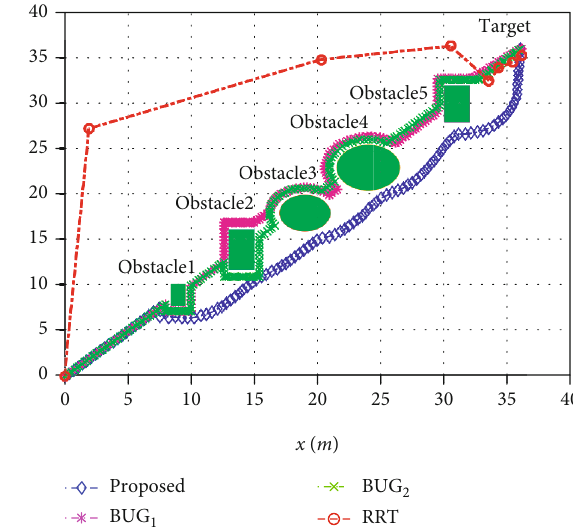
Figure 13: Scenario 1: the result of path planning of the four algorithms with multiple obstacles.